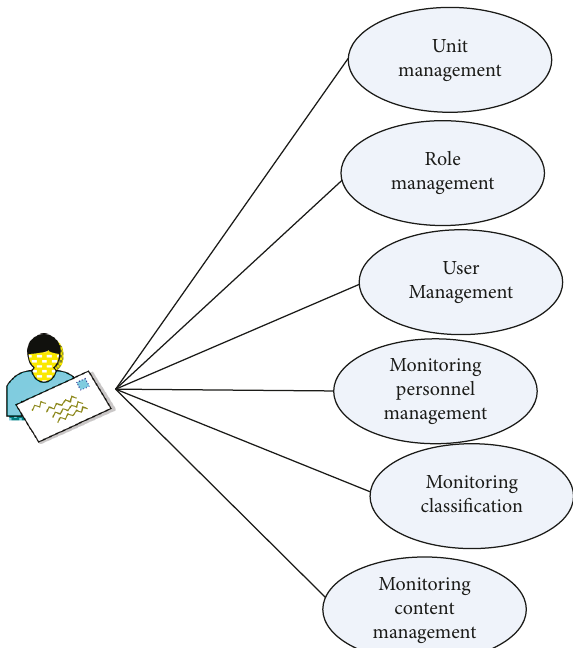
Figure 4: Configuration requirements for